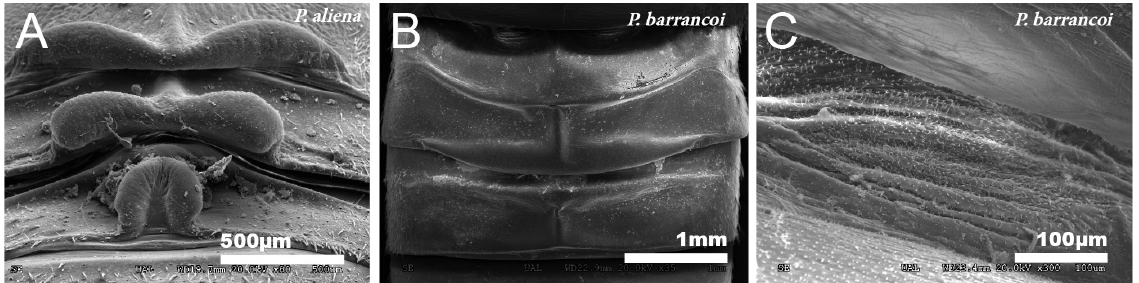
Figure 9. Dorsal glands. SEM pictures showing the dorsal glands in males of the genus Petaloptila ( A – C ). Within the subgenera of the taxon, they appear more developed and with variable structures and characteristics of each species in the subgenus Petaloptila ; in the image, we observe those present in P. aliena ( A ). In the subgenus Zapetaloptila, there is a reduction in the structures, as can be seen in P. barrancoi ( B ). The secretory surface is similar in all cases studied. ( C ) SEM image of the secretory surface in the interguite membrane, P. barrancoi .